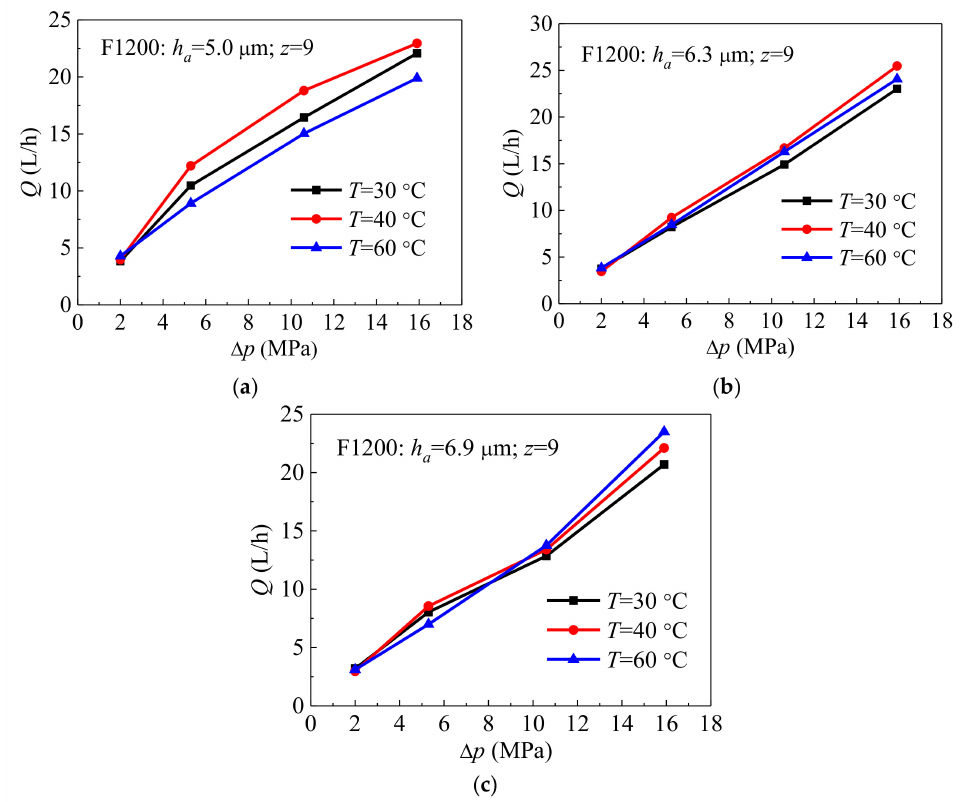
Figure 8. The comparison of the leakage rate at di ff erent temperature, including ( a ) h a = 5.0 µ m, ( b ) h a = 6.3 µ m, ( c ) h a = 6.9 µ